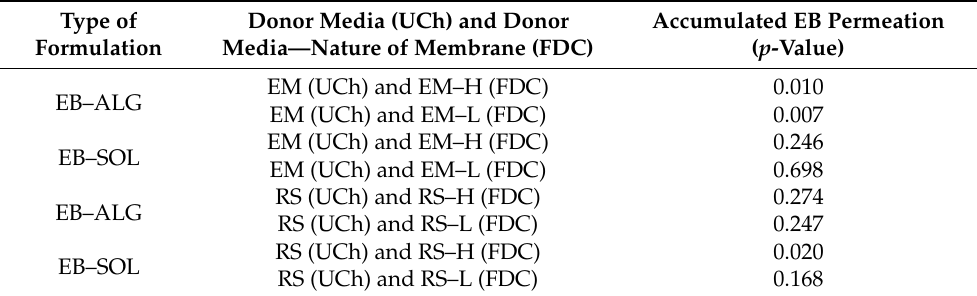
Figure A2. Dissolution rate of EB in biological membranes. Red squares represent EB–ALG microparticles, black triangles represent EB–SOL microparticles, and magenta circles represent free EB. ( a ) Represents emulsion as donor media with biological membrane and ( b ) Represents Ringer solution as donor media with biological membrane. Values represent the mean with standard deviation, n = 5. Table A1. Analysis of variance (ANOVA) between synthetic and biological membrane in the dissolution/permeation results.